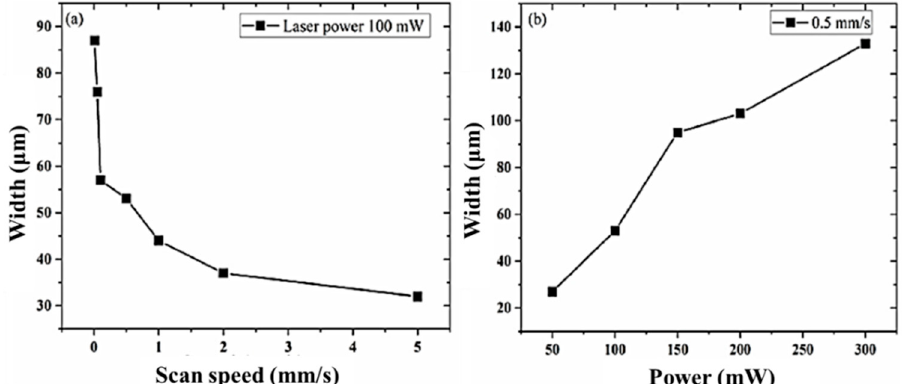
Figure 18. ( a ) Track width as a function of varying scan speeds with a constant laser power of 100 mW; ( b ) track width as a function of varying laser powers with a constant scan speed of 0.5 mm/s (Adapted from reference [56]).